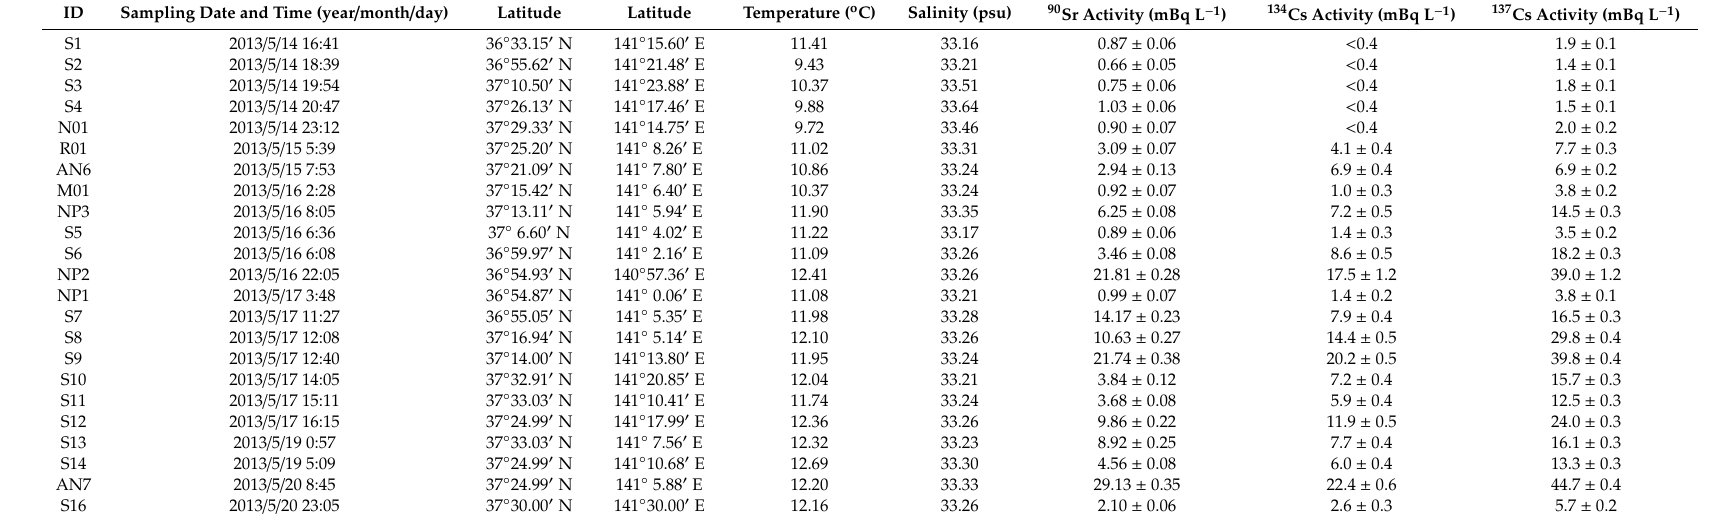
Table 1. 90 Sr, 134 Cd, and 137 Cs activities and hydrographic data in seawater collected on the Fukushima Prefecture coast in May 2013. Uncertainties represent 1 σ error. ID Sampling Date and Time (year / month / day) Latitude Latitude Temperature ( o C) Salinity (psu) 90 Sr Activity (mBq L − 1 ) 134 Cs Activity (mBq L − 1 ) 137 Cs Activity (mBq L − 1 )